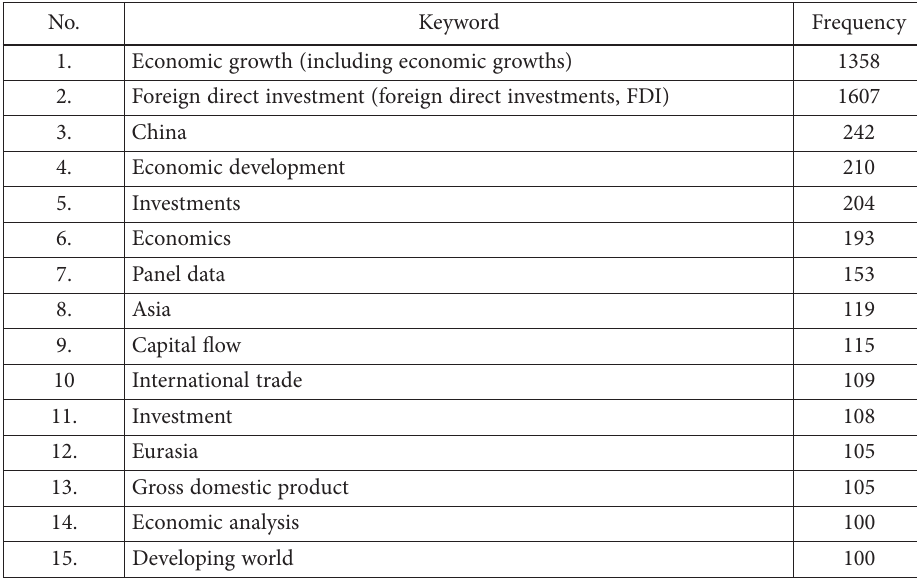
Table 3. Keywords with a minimum frequency of 100 (source: Autor analysis, based on VOSViewer) No.